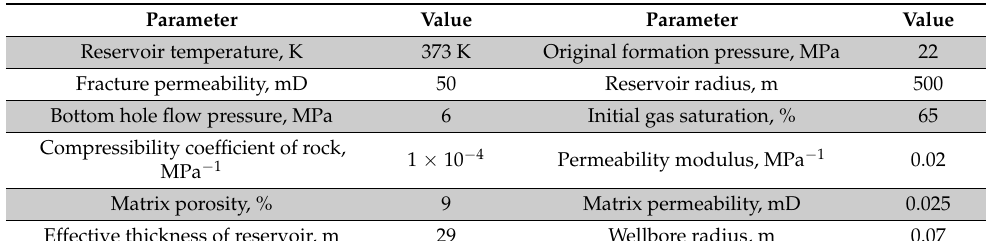
Figure 2. Schematic of the gas PVT properties.